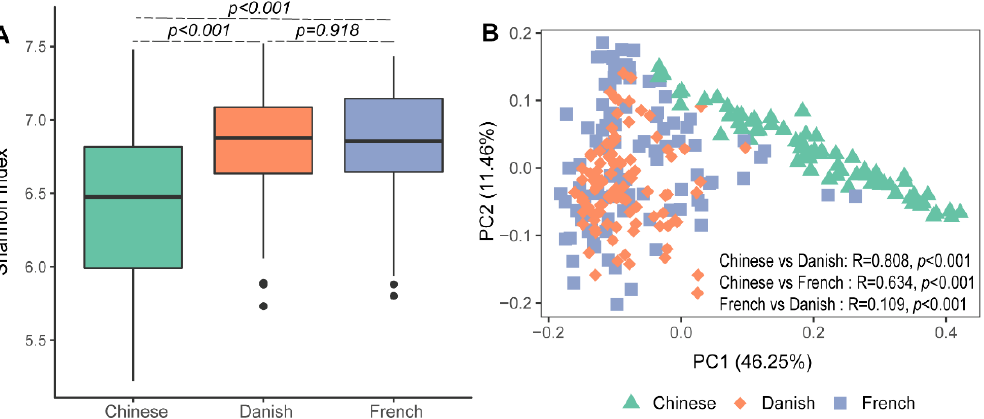
Figure 1. Swine archaeal alpha and beta diversities between three countries. Alpha diversity of archaeal communities in pigs was measured using the Shannon Index ( A ). Beta diversity was illustrated on a principal coordinate analysis (PCoA) plot based on Bray–Curtis distance ( B ).